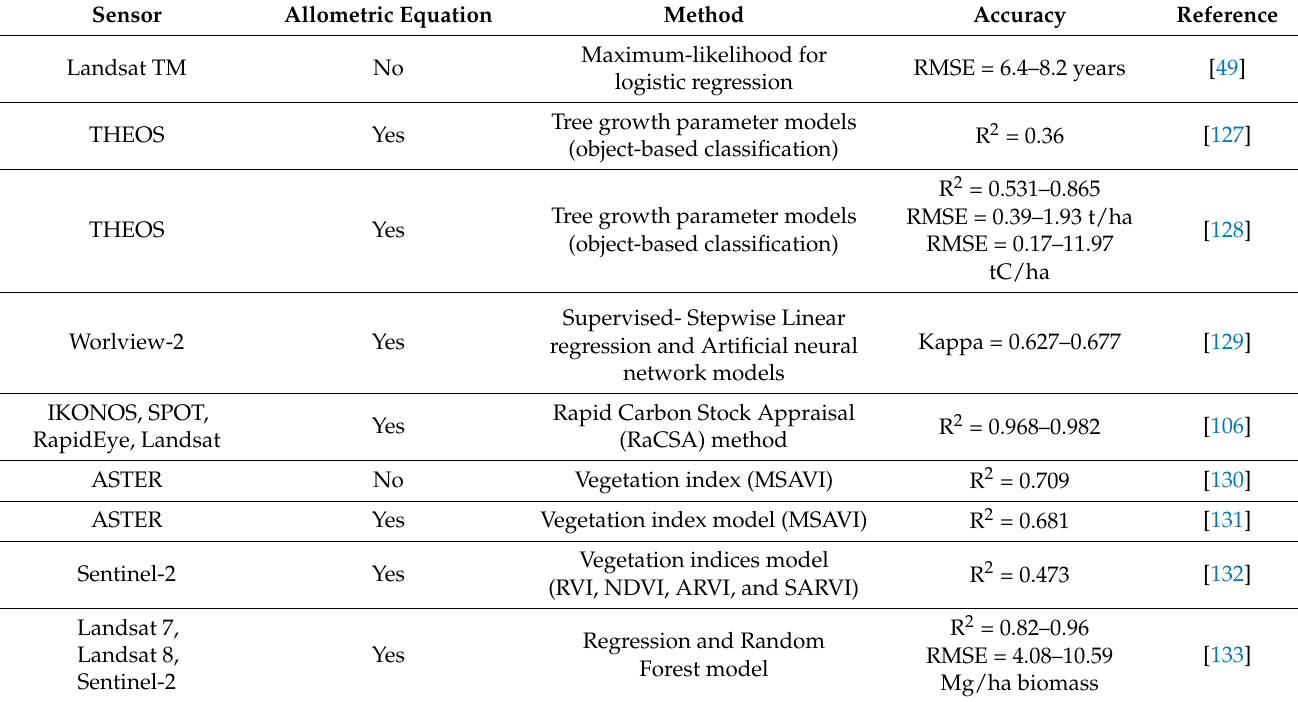
Table 7. Comparison of method and accuracy in biomass and carbon estimation related